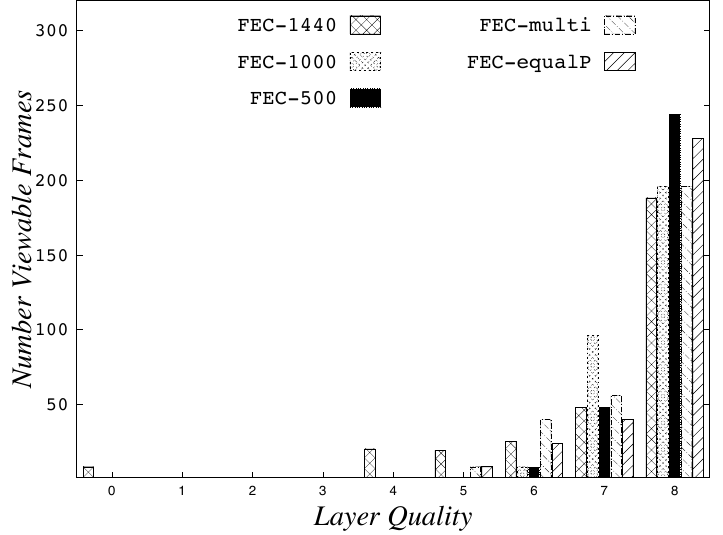
Figure A14. Example of the number of viewable layers for SVC-SC, for each of the FEC max Packet thres , at a packet loss rate of 10% and a GOP of 8. This image illustrates an increase in the FEC max for C1 and C2 based on the worst case scenario, as shown in Table